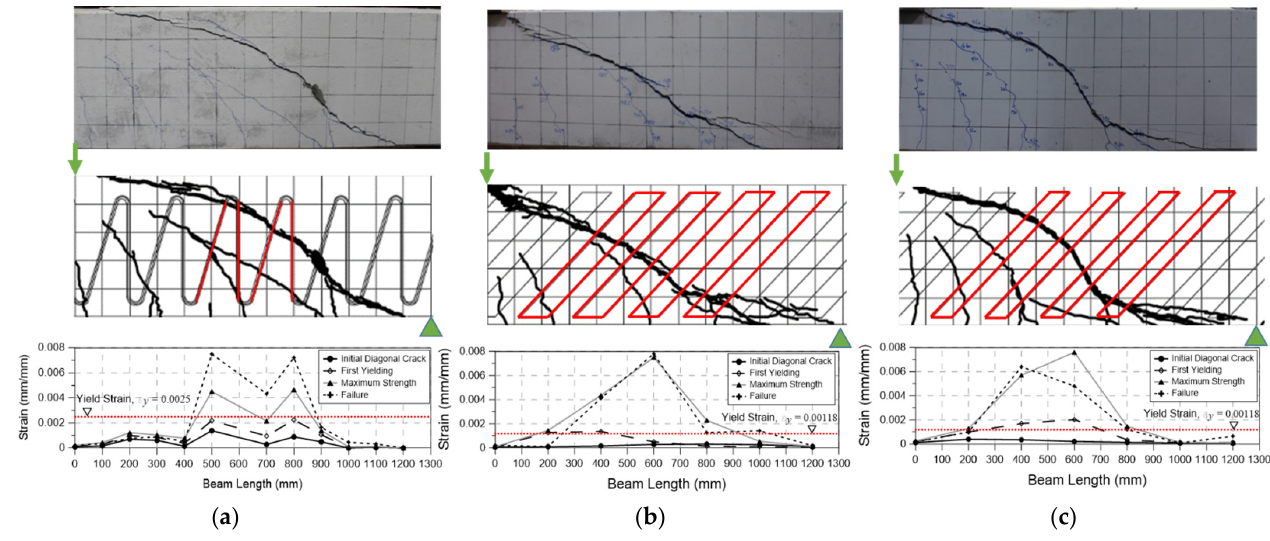
Figure 11. Strain distributions of the rebar and steel plate shear reinforcements. ( a ) BS-N. ( b ) BS-2T. ( c ) BS-2.5T.